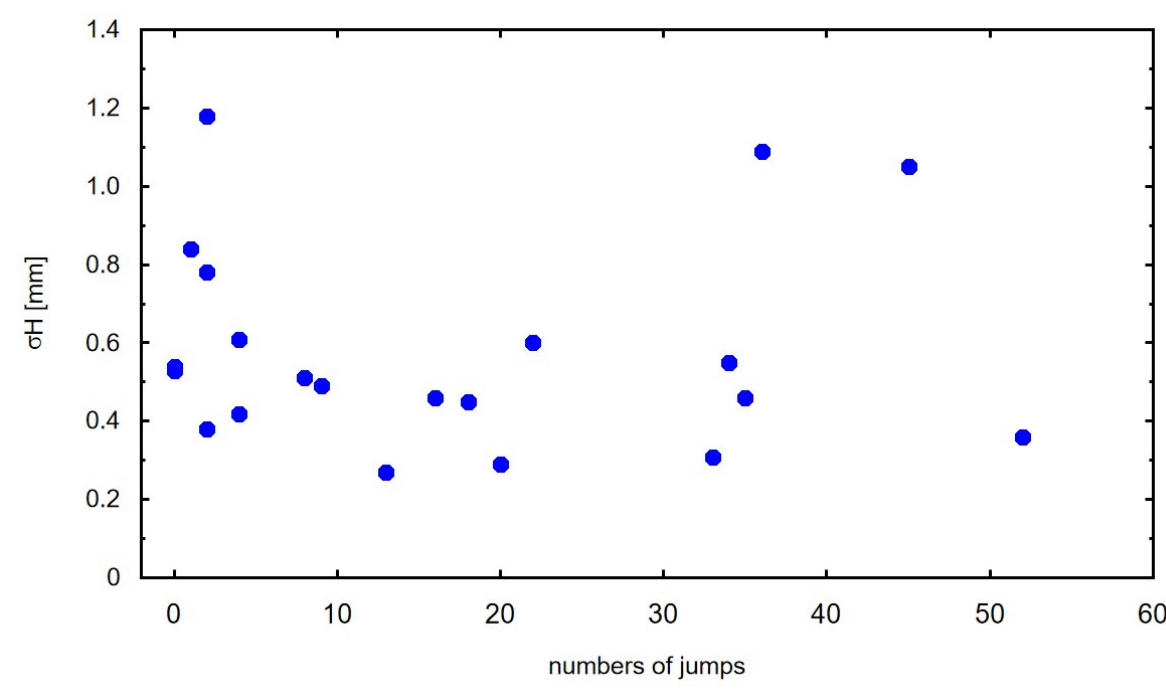
Figure 8. The influence of height determination error σ H on the number of jumps in the analysed time series of coordinates from the GNSS station.